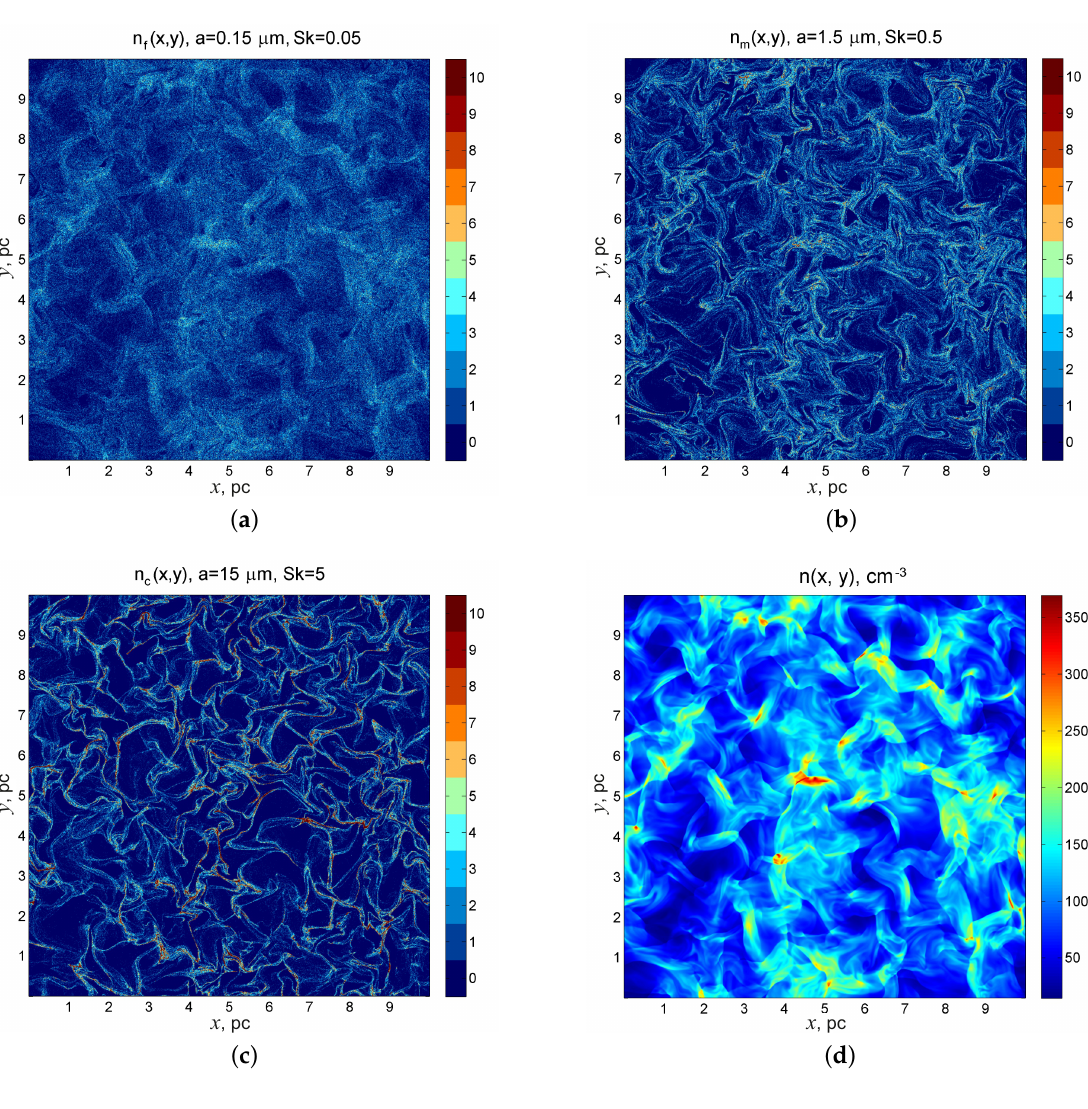
Figure 2. The distribution of the concentrations of individual dust fractions at the same time in a turbulent molecular cloud model for particles of different sizes is: ( a ) a = 0.15 µ m; ( b ) a = 1.5 µ m; ( c ) a = 15 µ m. The corresponding Stokes numbers Sk are given in the headings to the figures. The discrete color scale on the vertical bar compares the color to the number of particles in the cell. The distributions are cut off from above by the maximum displayed number of particles: if the number of particles in the cell is greater than 10, then the number of particles in the figure is displayed as 10. ( d ) shows the distribution of gas concentration at the same